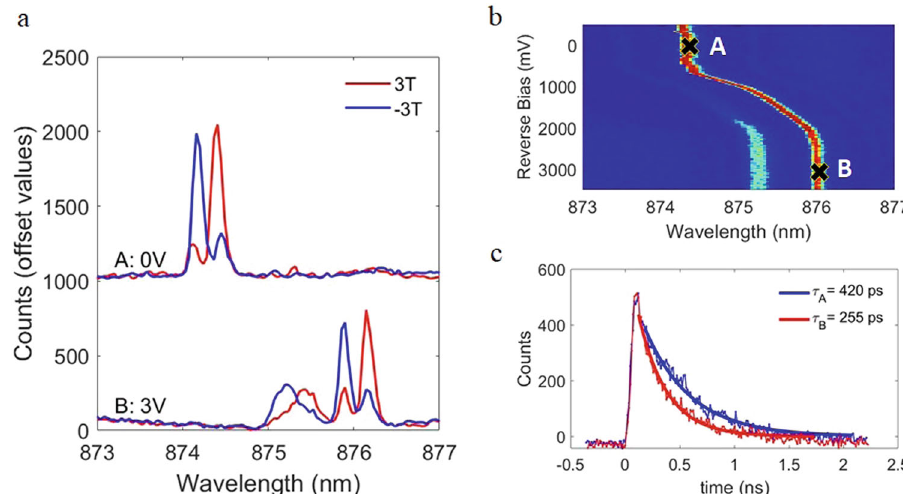
Fig. 4 Purcell-enhanced chirally coupled QD. a Chiral measurements of a QD near the slow-light region. The PL was collected from the right outcoupler of the device. Strong chirality was observed using magnetic fi eld at 3 T (red line) and − 3T (blue line) for both 0 V bias (A point), and 3 V bias (point B). The broad line that emerges below the QD at 3 V might be a charge state with short lifetime or another QD. b PL scan for the chirally coupled QD. c Lifetime measurement for the QD at point A (red) and point B (blue) using non-resonant excitation pulse laser at 808 nm. The fi tted decay time decreased from 420 ps to 255 ps on red-shifting the QD emission line from 874.4 (point A) to 876.1 nm (point